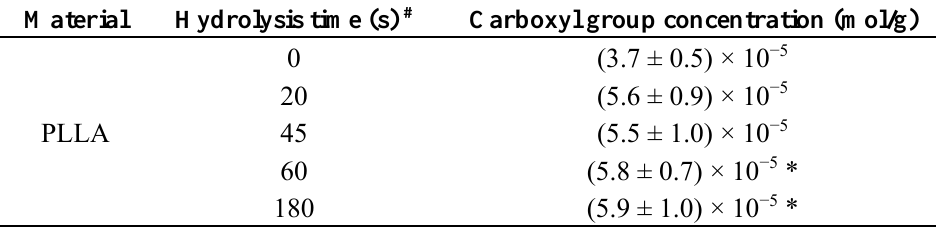
Table 1. Total carboxyl group concentration (mol/g) inserted into PLLA scaffolds as a function of the reaction time (min).